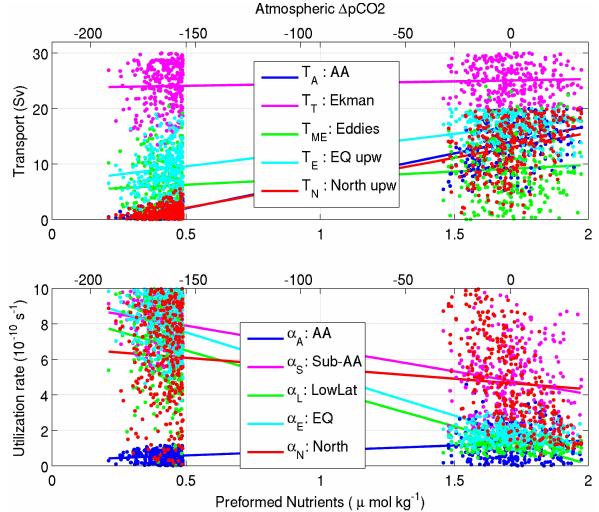
Fig. 3. The circulation (top) and nutrient utilization rate (bottom) parameters of the interglacial states (right) and the glacial states (left) are shown here against the preformed nutrient concentration in the deep ocean. The top axis relates the difference in preformed nutrient between the glacial and interglacial states to changes in at- mospheric p CO 2 (as discussed in Sect. 2.2). Best fit lines are drawn through the solutions for visual aid. They do not imply an indepen- dent linear correlation between the preformed nutrient concentra- tions and the input parameters.